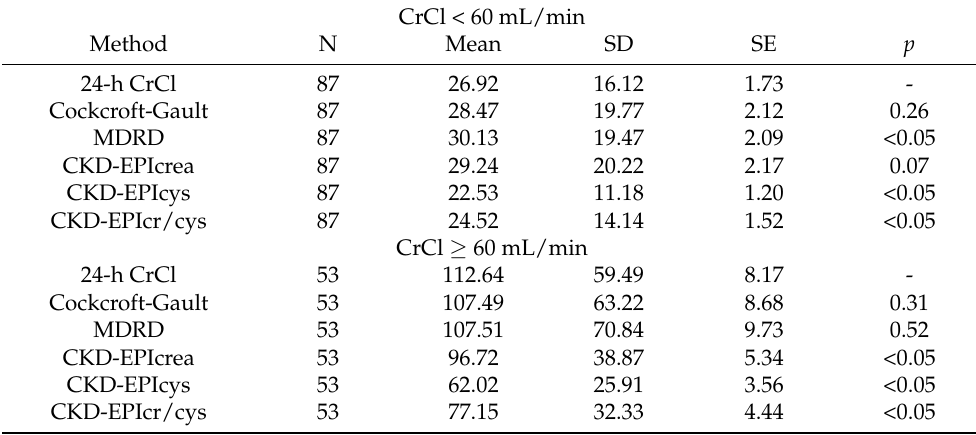
Table 7. Comparison of methods for 24-h CrCl < 60 mL/min vs. 24-h CrCl ≥ 60